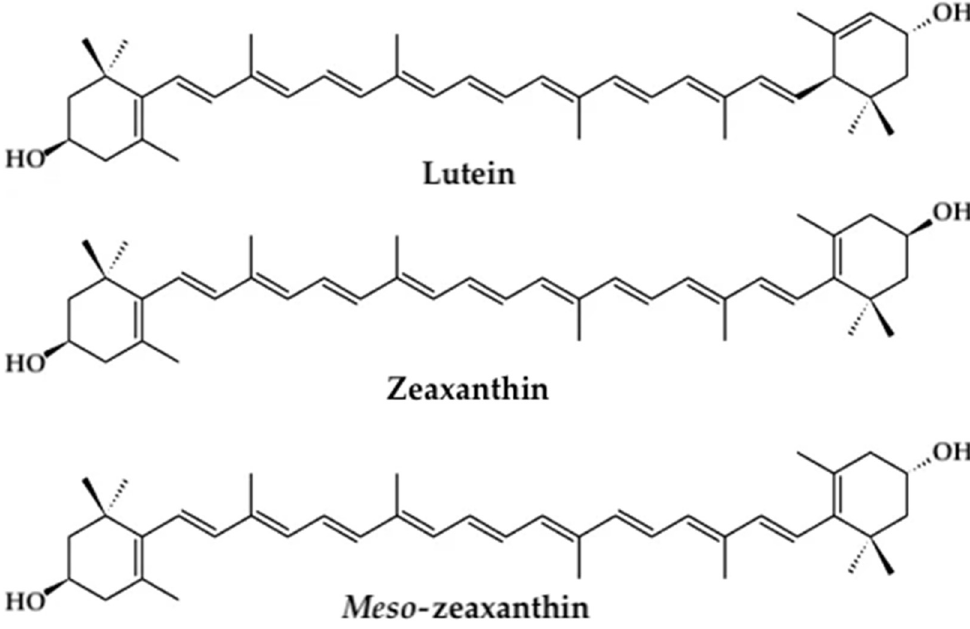
Figure 1. Chemical structures of the xanthophyll carotenoids lutein, zeaxanthin, and meso - zeaxanthin.